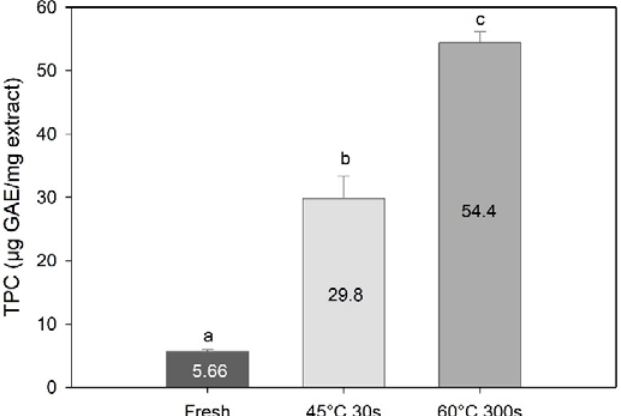
Figure 6. Total phenolic content expressed in gallic acid equivalents per mg of methanolic extract of Saccharina latissima from fresh and two types of blanching. Data are mean ± SD; n = 3. Di ff erent letters represent a significant di ff erence ( p < 0.05) between treatments.